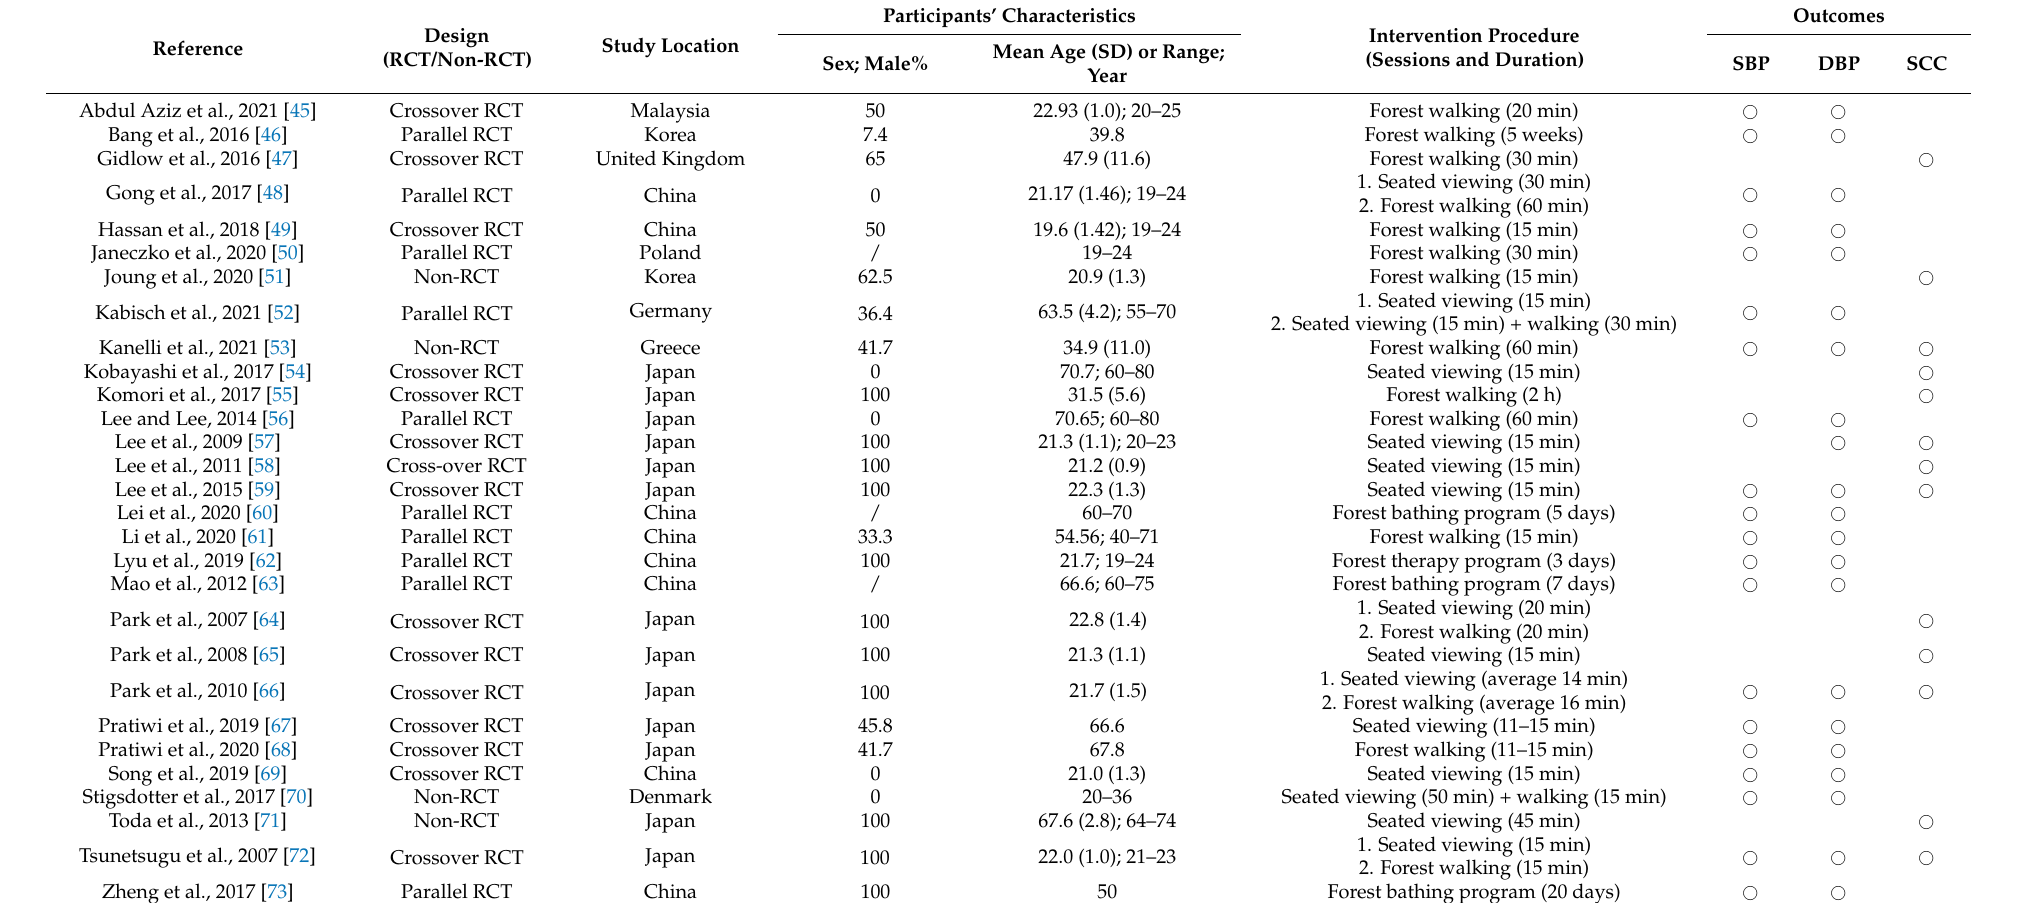
” symbol indicates that an outcome was measured in the included